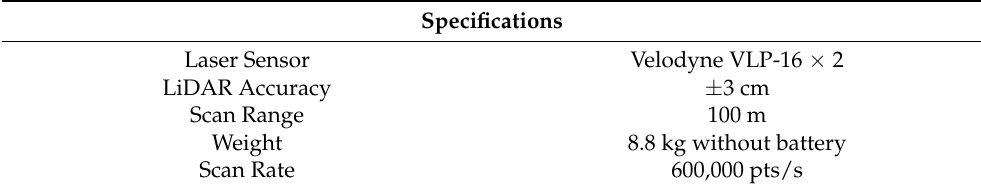
Table 3. Technical specifications of the backpack personal laser scanning device (BPLS, Liback- pack D50).